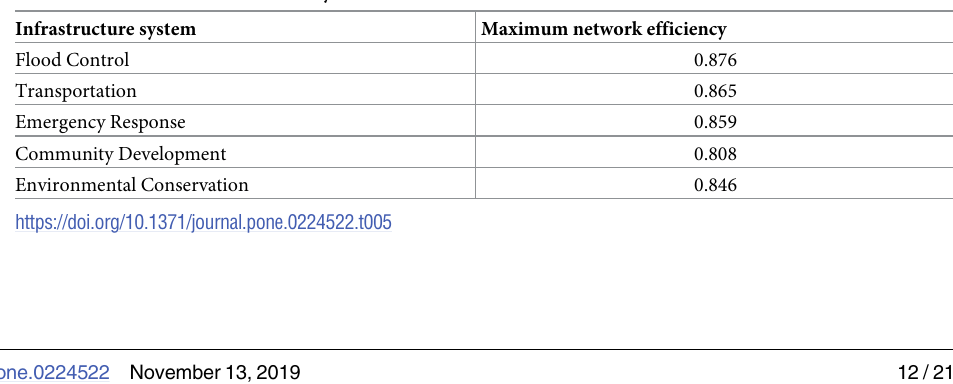
Table 5. Maximum network efficiency within